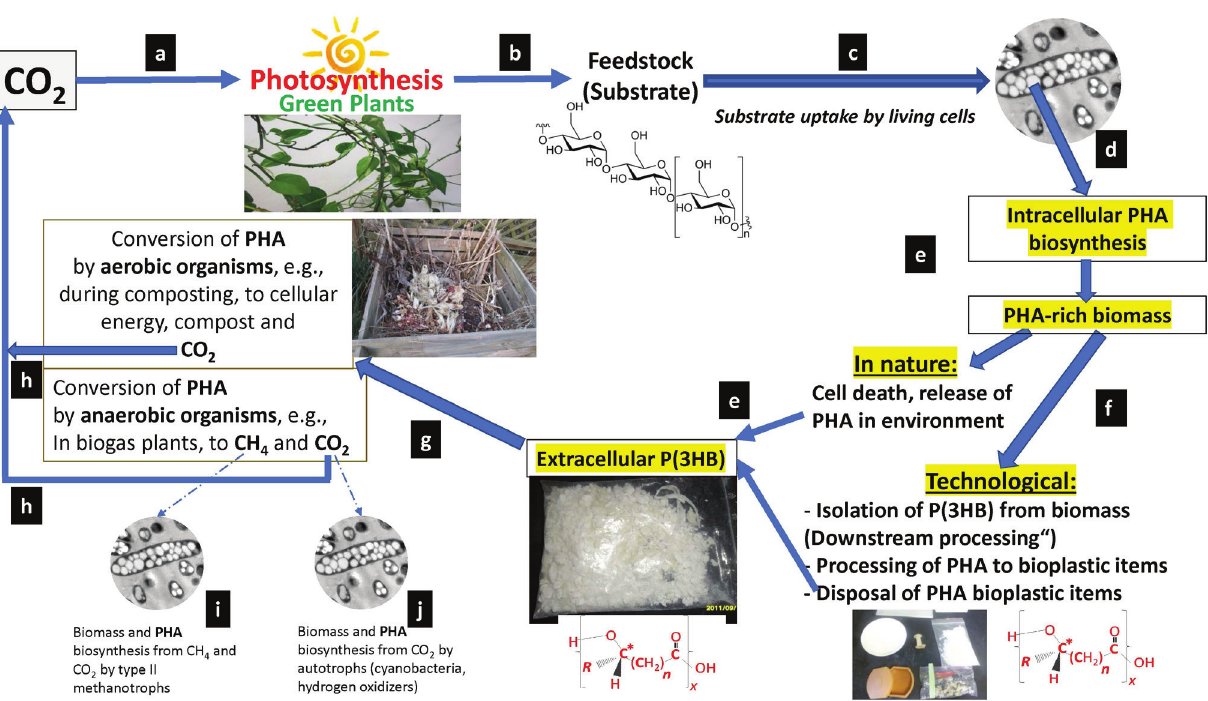
Fig. 1 – Circularity of PHA biopolyesters. (a) Photosynthetic fixation of CO by green plants; (b) Formation of carbonaceous feed- 2 stocks (e.g., carbohydrates) by green plants based on photosynthetic fixation of CO ; (c) Feedstock (substrates) are metabolized by 2 PHA-producing microbes; (d) Intracellular accumulation of PHA granules by microbes based on consumed substrates; (e) Release of PHA granules into the environment after cell death; (f) Technological downstream processing for recovery of PHA from cell biomass, followed by processing of recovered PHA to vendible bioplastic items, and disposal of PHA-based items after use; (g) End-of-life fate of disposed PHA-based items by aerobic biodegradation via composting (generates CO ) or anaerobic fermentation to CO plus CH 2 2 4 in biogas plants; (h) CO generated during these processes is again photosynthetically fixed by green plants: The cycle is closed! (i) 2 Some type II methanotrophic microbes can directly metabolize CH stemming from anaerobic PHA digestion to PHA; (j) Several au- 4 totrophic microbes like various cyanobacteria directly convert CO stemming from PHA digestion to 2